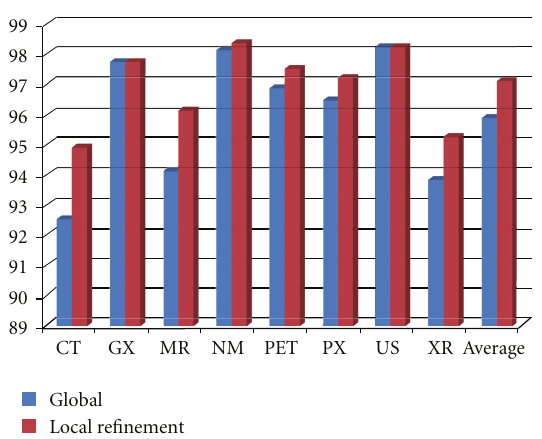
Figure 5: The compared recognition rates for all modalities. Blue bar: without refinement using local classifiers; Red bar: with refinement.